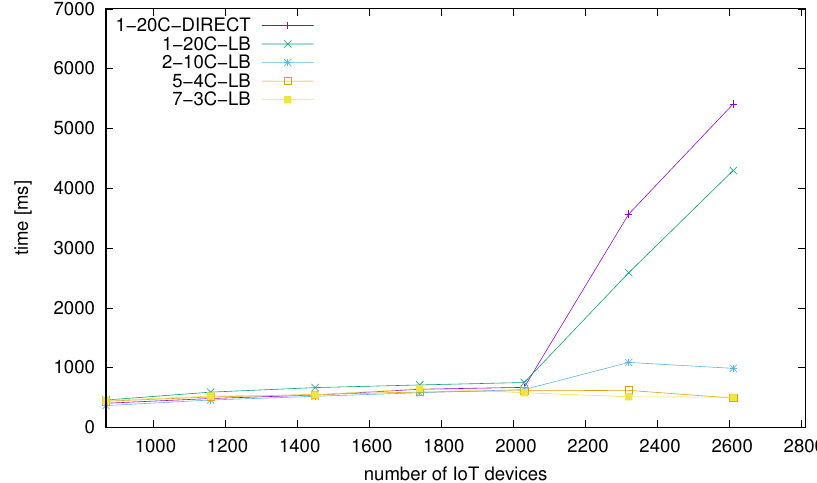
Figure 14. Median value of processing time request-response (client